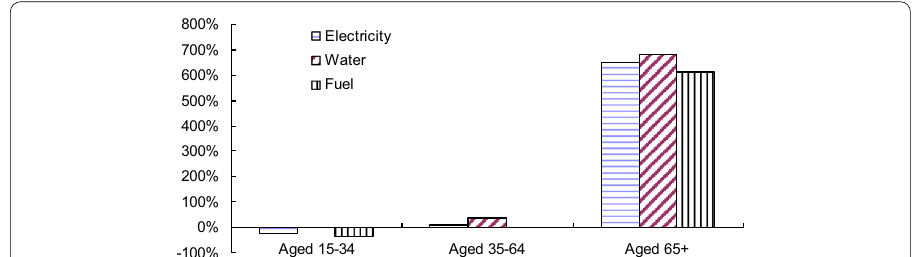
Fig. 4 Relative increase of residential energy demands in 2050 as compared to 2010 by ages of householder